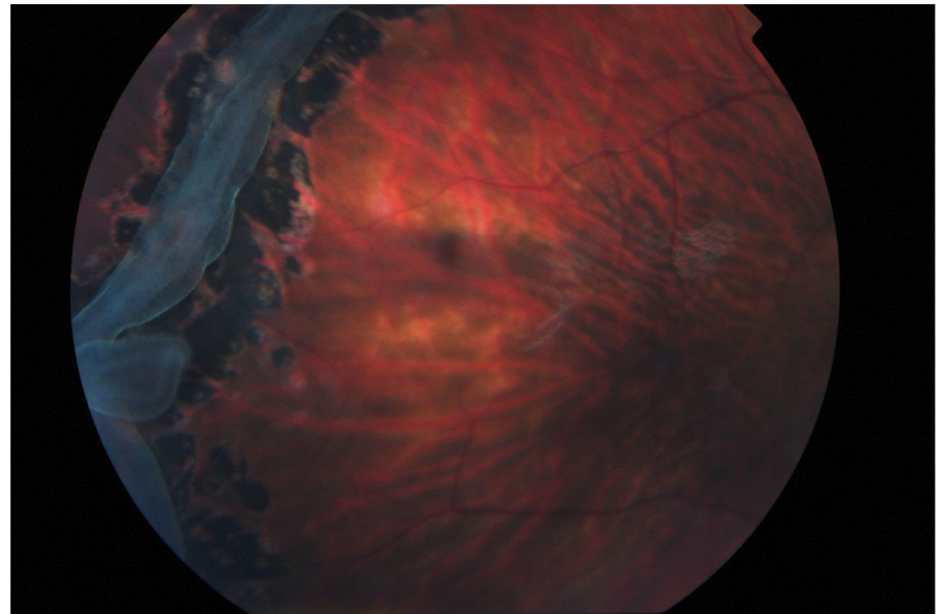
Figure 3. Laser retinopexy to arrest the progression of a giant retinal tear in type 1 Stickler syndrome (no previous prophylaxis). Reproduced with permission from Snead, MP (2022): Retinal detachment